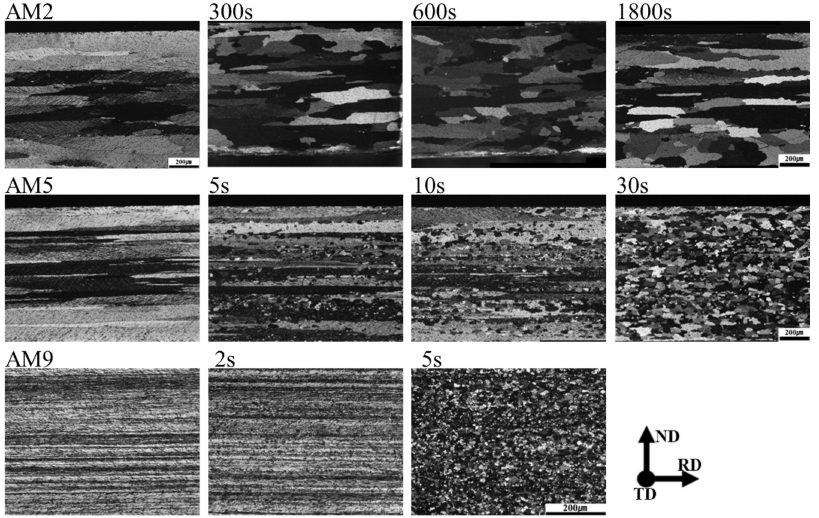
Figure 11. Evolution of the recrystallization microstructure for the AM2, AM5, and AM9 at 350 ◦ C for different holding